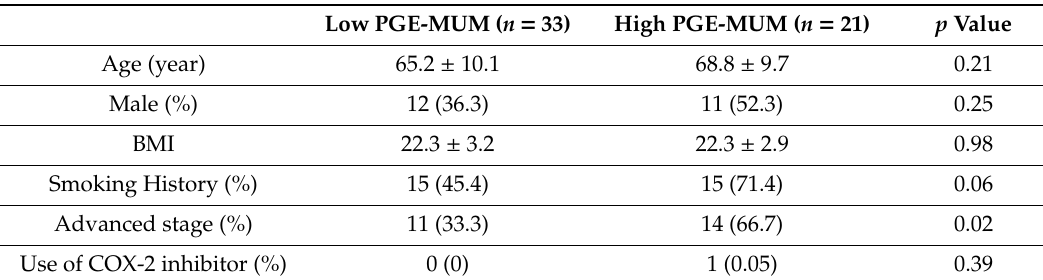
Table 2. Univariate analysis of clinical factors association of with high PGE-MUM. The e ff ects of clinical characteristics (age, sex, BMI, smoking history, advanced stage, and use of a COX-2 inhibitor) on PGE-MUM levels were examined.